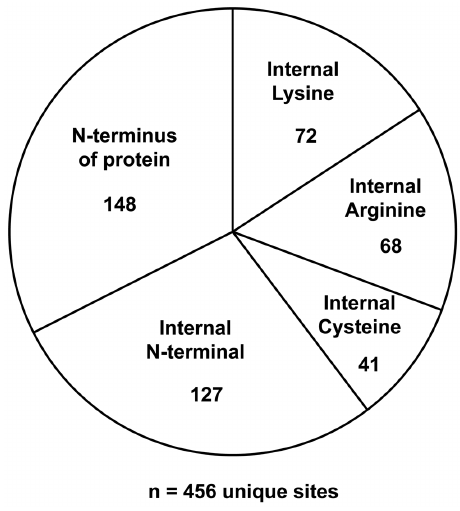
Figure 4. Categories of endogenous carbamylation sites found in inner medullary samples. The carbamylation sites identified are based on pooled mass spectrometry data of carbamyl sites identified in two rats. Rats were treated with furosemide 30 minutes before sacrifice but otherwise were untreated.